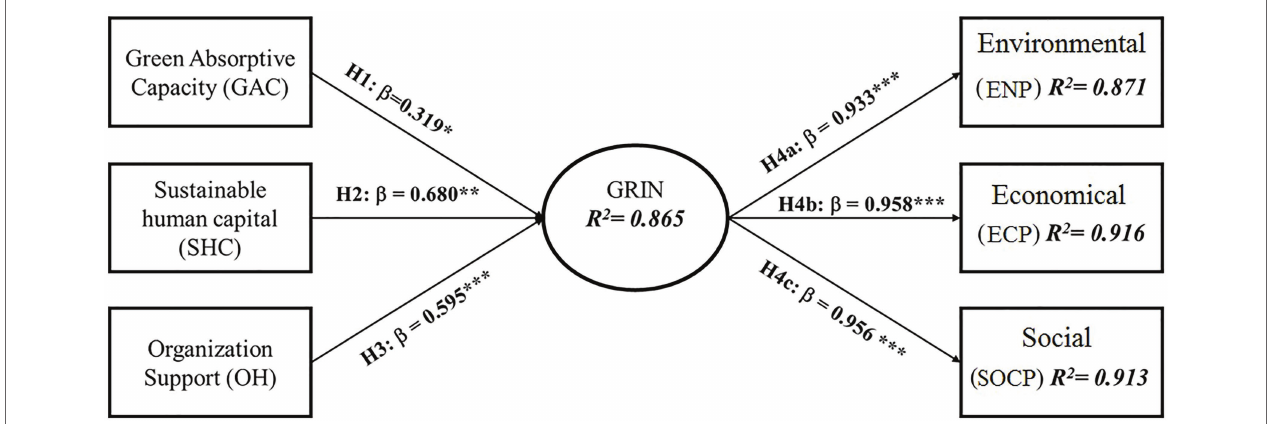
TABLE 5 | Multi group analysis (firm size). Relationships